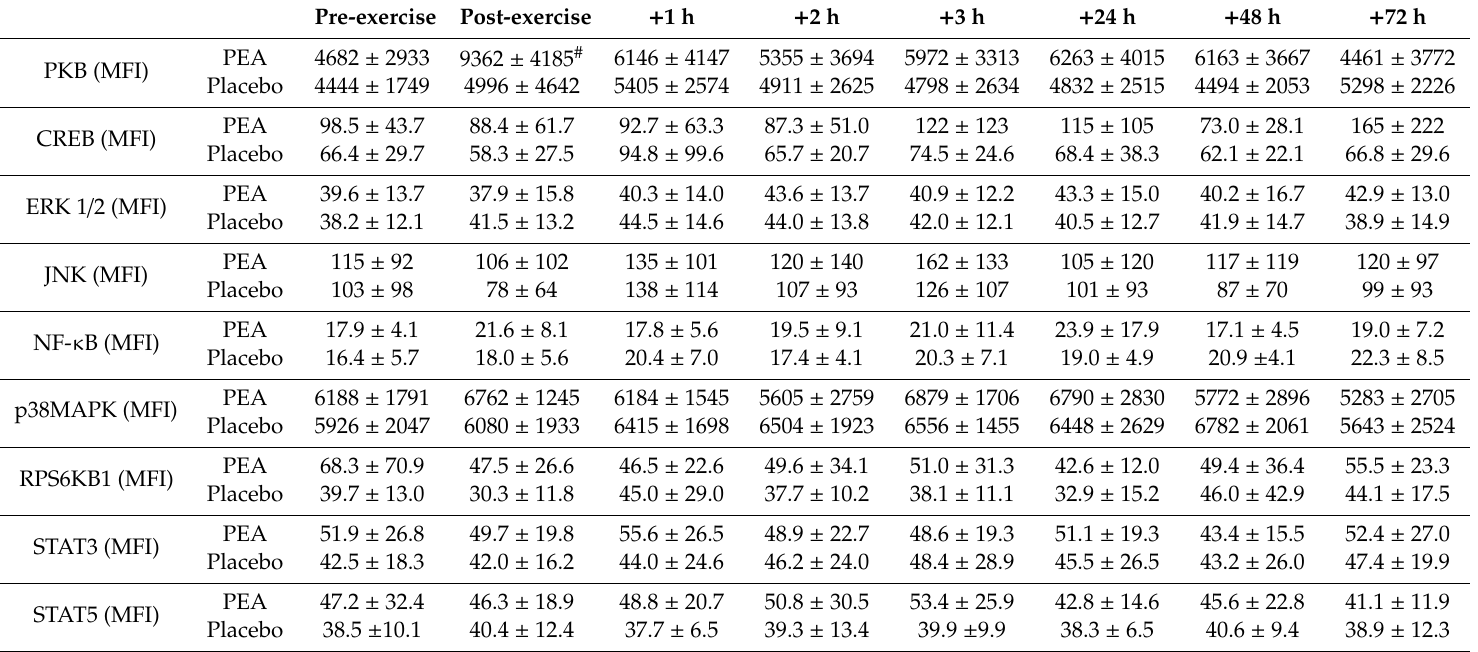
Table 2. Phosphoprotein signaling pathways for PEA and placebo groups. Values are mean ± SD, # p < 0.05 compared with pre-exercise. Pre-exercise